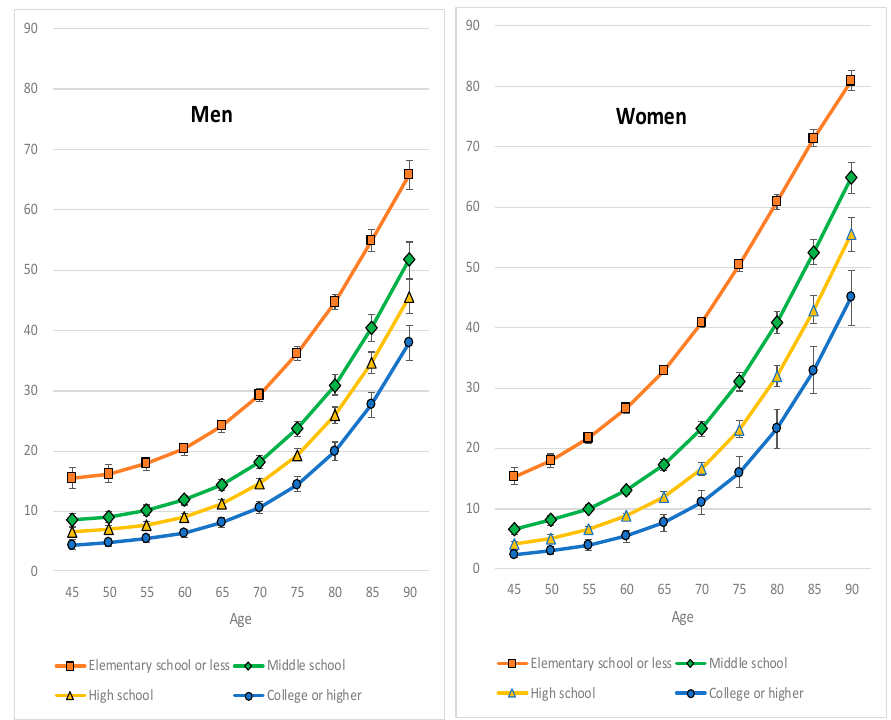
Figure 1. Gender-specific changes in the predicted probability (%) of having a cognitive impairment for each education level and their 95% confidence intervals with aging for all observations of all considered waves.